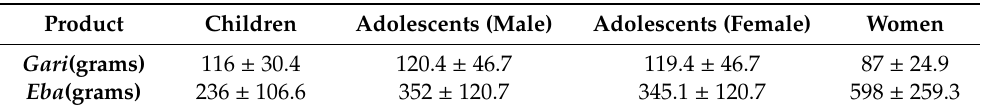
Table 4. Mean with standard deviation (in grams) of common cassava products (gari and eba) consumed by children, adolescents, and